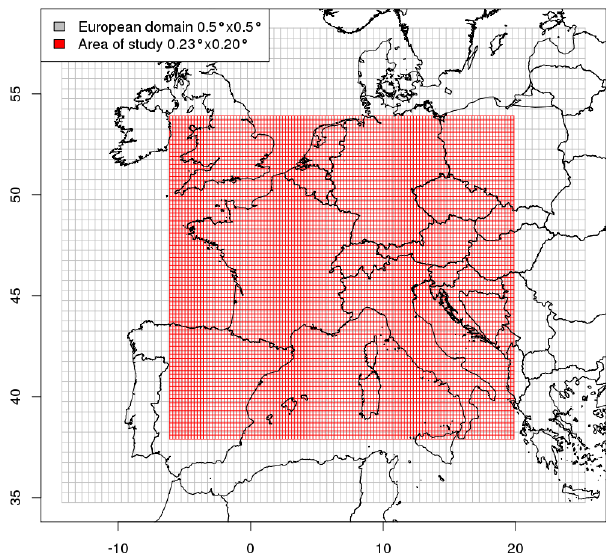
Figure 1. In red, gridded domain used for the air quality simu- lations, having a horizontal resolution of 0.23 ◦ × 0.20 ◦ . In black, large-scale domain used to provide boundary conditions (horizontal resolution of 0.5 ◦ × 0.5 ◦